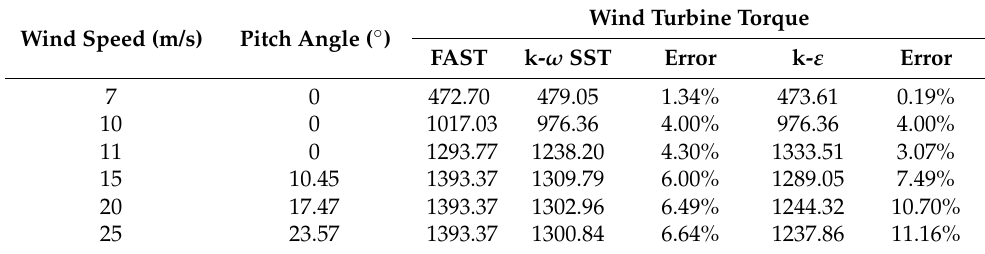
Table 3. Output torques based on the k- ω SST and k- ε models and